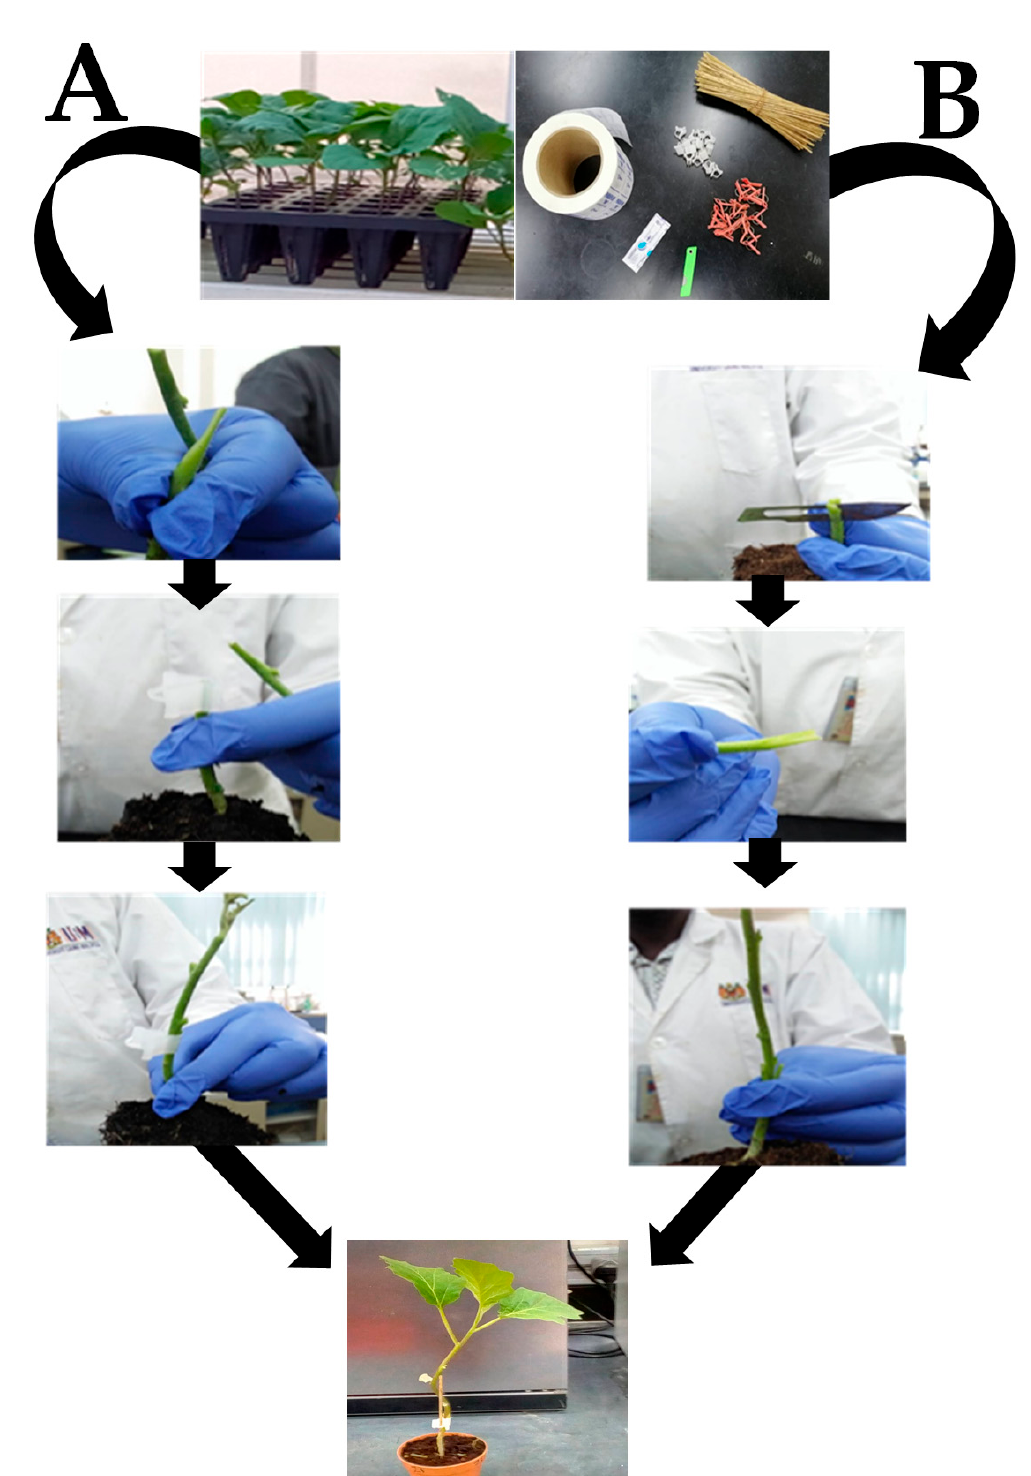
Figure 3. Grafting procedure for splice grafting ( A ) and cleft grafting ( B ) techniques.